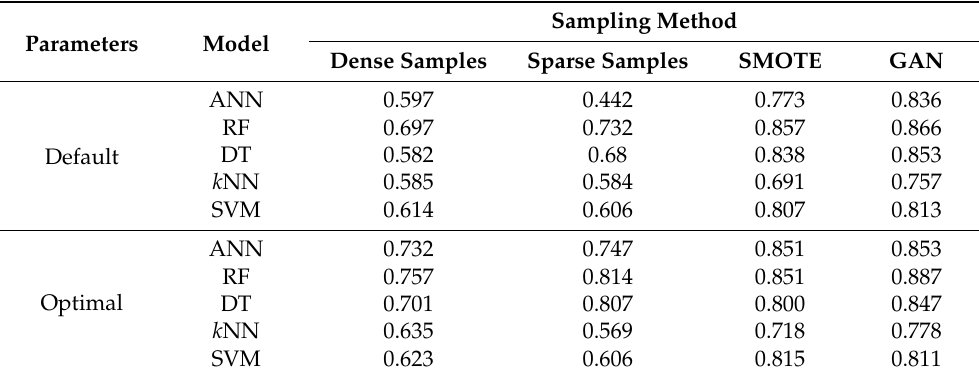
Table A2. Assessment of different sampling methods used in this study with five machine learning models (both default and optimised parameters)–based on Kappa Index.